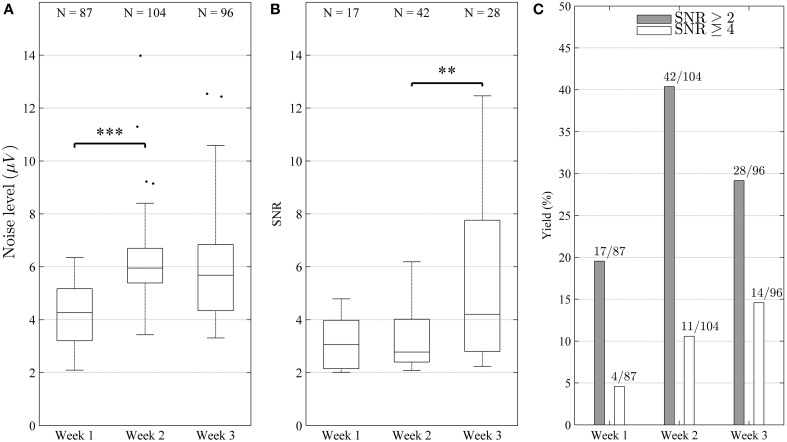
Characterization of electrode performance over time. (A) Noise level estimated by Equation (1) (distributions shown as median and percentiles values) including all electrode channels. The noise increased significantly (***p < 0.001) between weeks 1 and 2, but remained stable between weeks 2 and 3 (p > 0.05). (B) Signal to noise ratio (SNR) of single-units (distribution including all identified units shown as median and percentile values) remained stable (p > 0.05) between week 1 and 2, but increased significantly between week 2 and 3 (**p < 0.01). This reflects the fact that high amplitude units were added during week 3. The increase in SNR and yield suggest that the overall recording conditions improved during the course of the experiment. (C) Bar diagram depicting yield in percentage (number of channels with units divided by number of channels is shown on top of each bar). It can be seen that yield increased for both good (SNR ≥ 4) and fair (SNR ≥ 2) units (C), although the increase was not strictly monotonic for fair units (peaked during week 2).